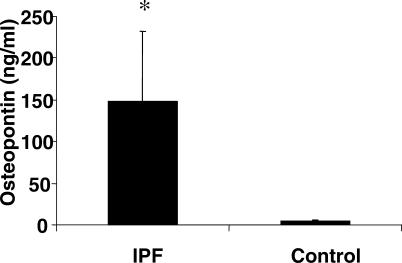
Osteopontin Levels in BAL FluidQuantification of osteopontin by ELISA was performed in BAL fluid samples from 18 IPF patients and 10 healthy individual controls. An increased concentration of soluble osteopontin was found in the BAL fluid obtained from IPF patients compared with healthy controls. The data represent the mean ± standard deviation (SD). * p < 0.01.